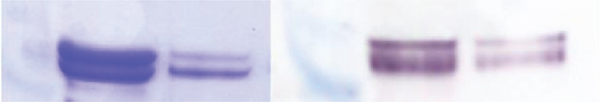
The SDS gel (left) and western blot (right, anti-His-tag antibody, penta-His conjugated) for the HCV helicase protein.